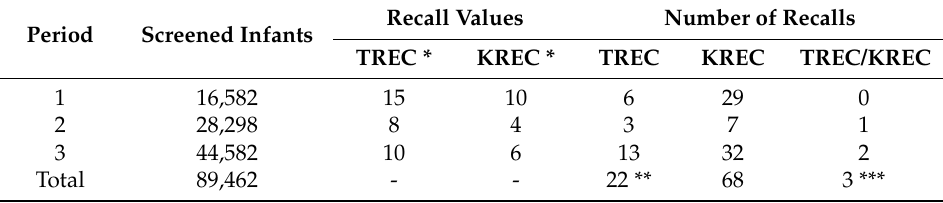
Table 1. Number of screened infants and recalls, with cut-offs used during different periods. Recall Values Number of Recalls Period Screened Infants TREC *